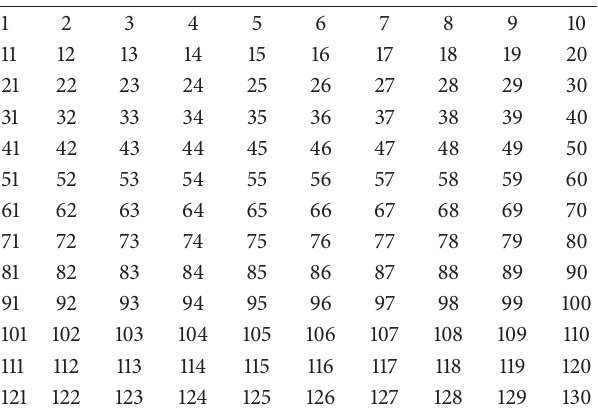
∗ The bold numbers are in wrong position. Table 8: The correct order.